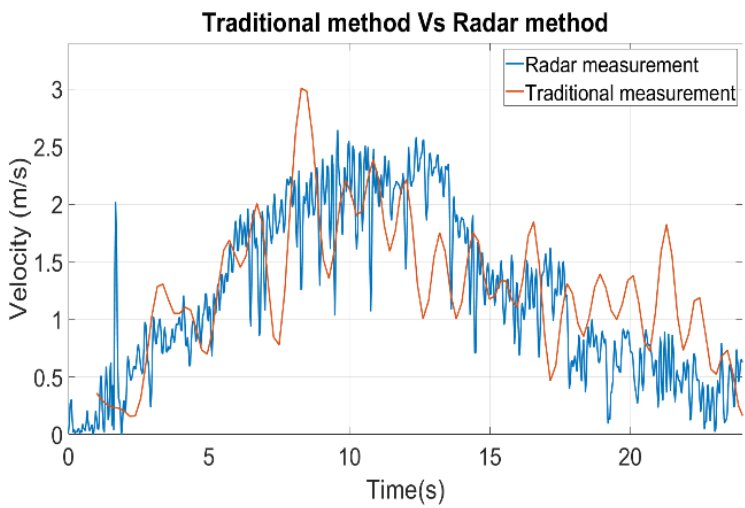
Figure 6. Trial 1, traditional measurement result plot vs. radar measurement result plot.